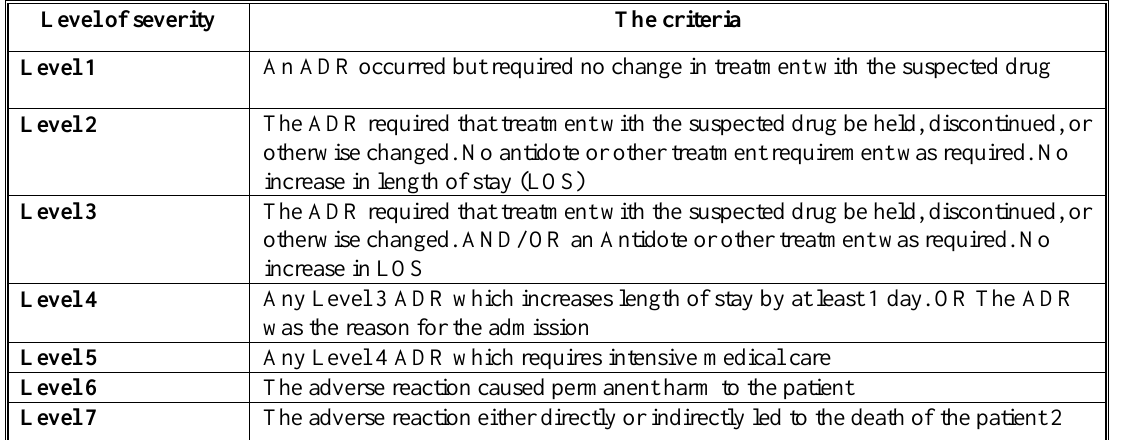
Table 2 ， Hartwig’s Severity Assessment Scale (19)